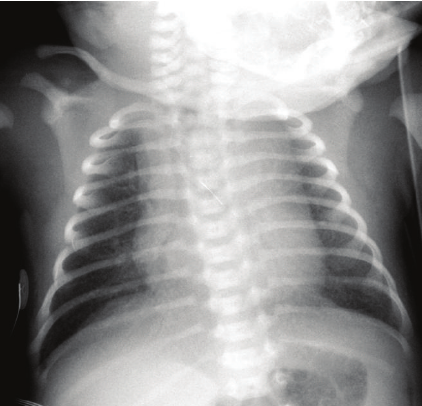
Figure1:Frontalviewofthechestdemonstratesmildhyperinflation and mild diffuse air-space disease.